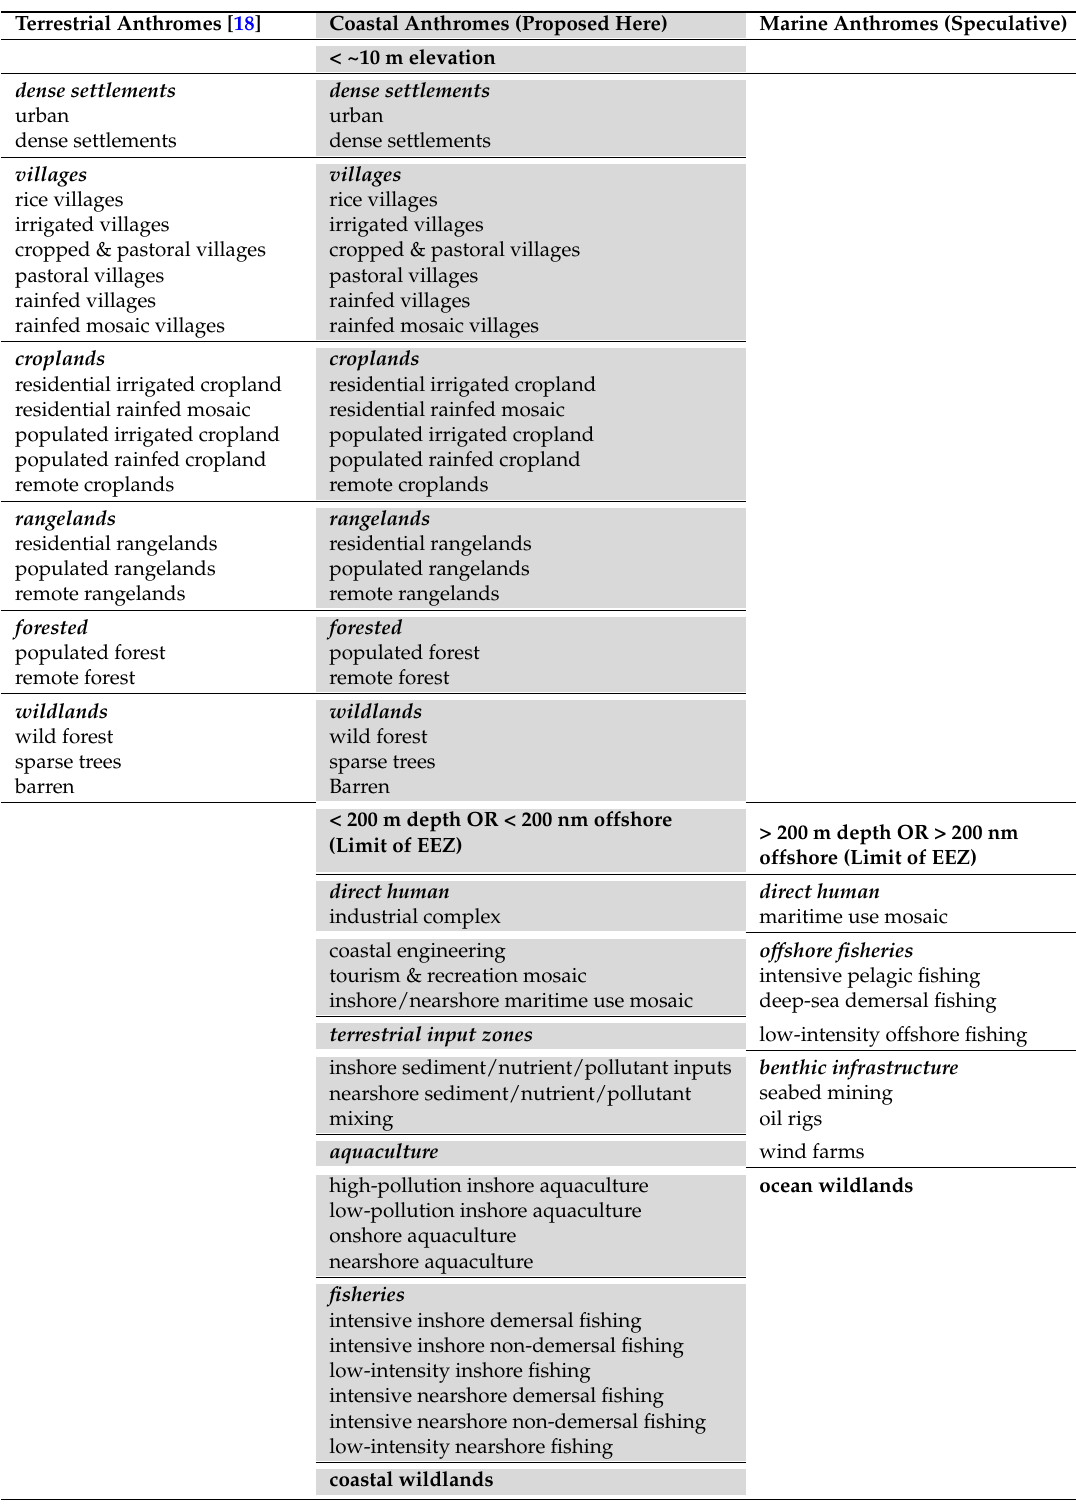
Table 2. A proposed set of coastal (and marine) anthrome classes, based on the original classification by Ellis and Ramankutty